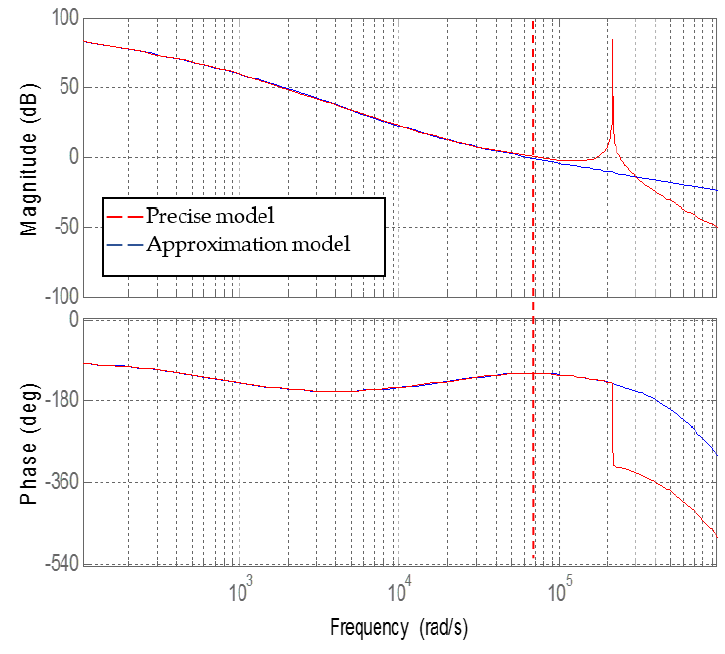
Figure 8. Bode plot of the approximated model and the precise model.